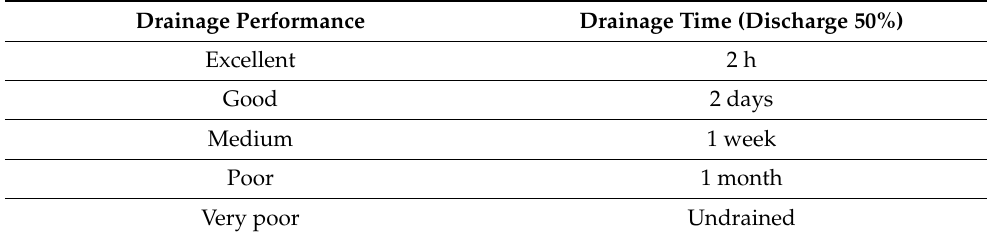
Table 11. Performance rating of paving layer drainage